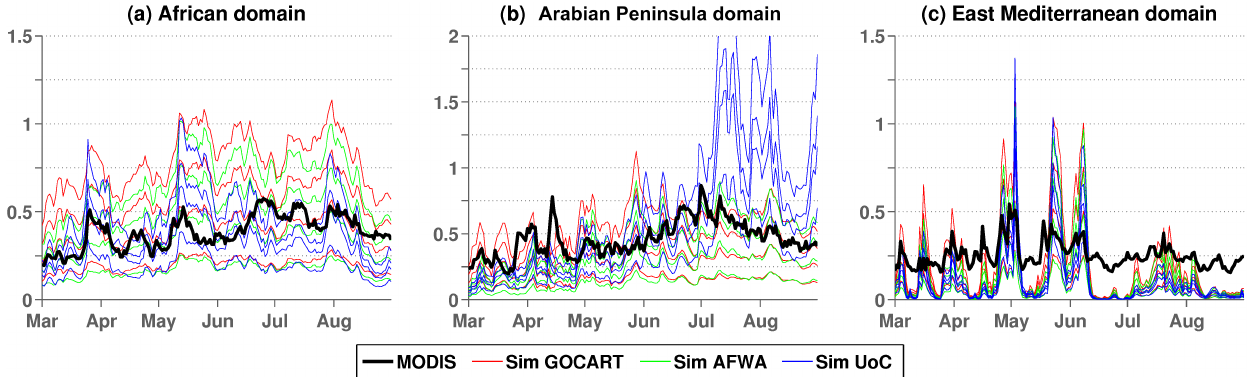
Figure 6. Time series of the daily averaged AOD for the simulations and MODIS for the whole 6-month period, averaged over the three sub-domains depicted in Fig.